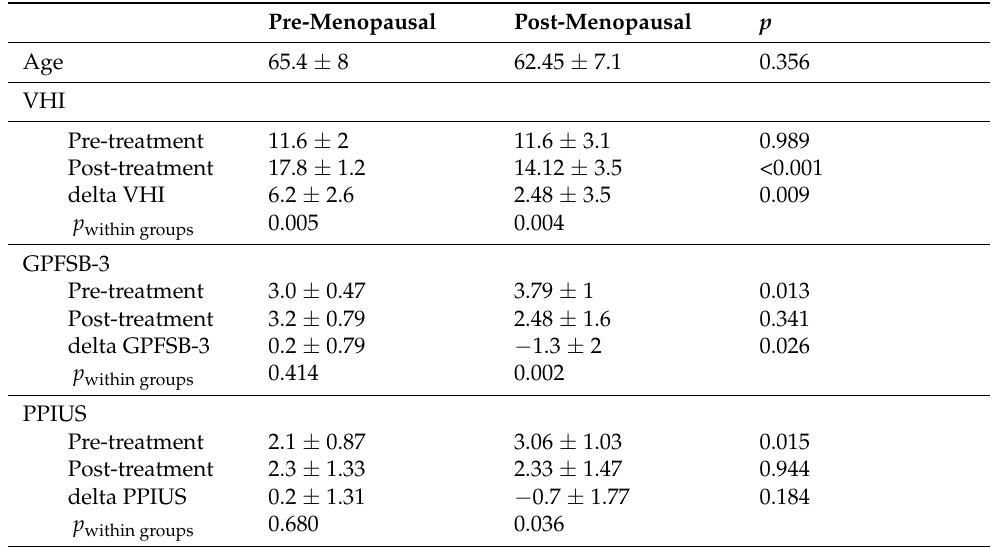
Table 1. Comparison between pre- and post-menopausal onset of overactive